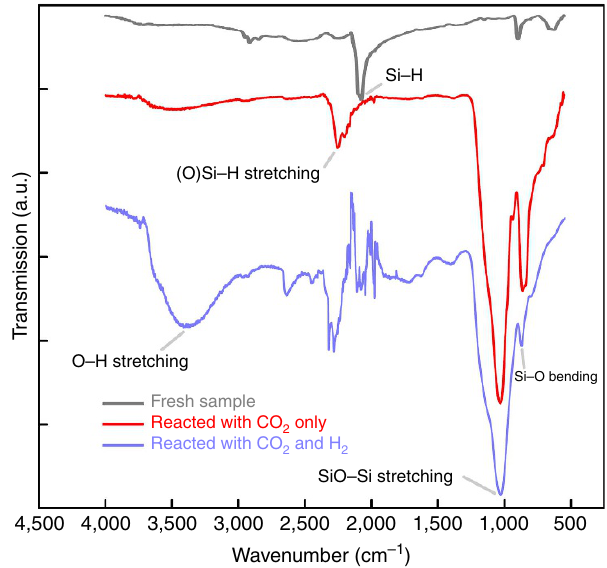
Figure 3 | FTIR study of surface properties. FTIR spectra of fresh ncSi:H powder before the reaction, after the reaction with 13 CO 2 only for over 160h, and after the reaction with both 13 CO 2 and H 2 for over 200h.